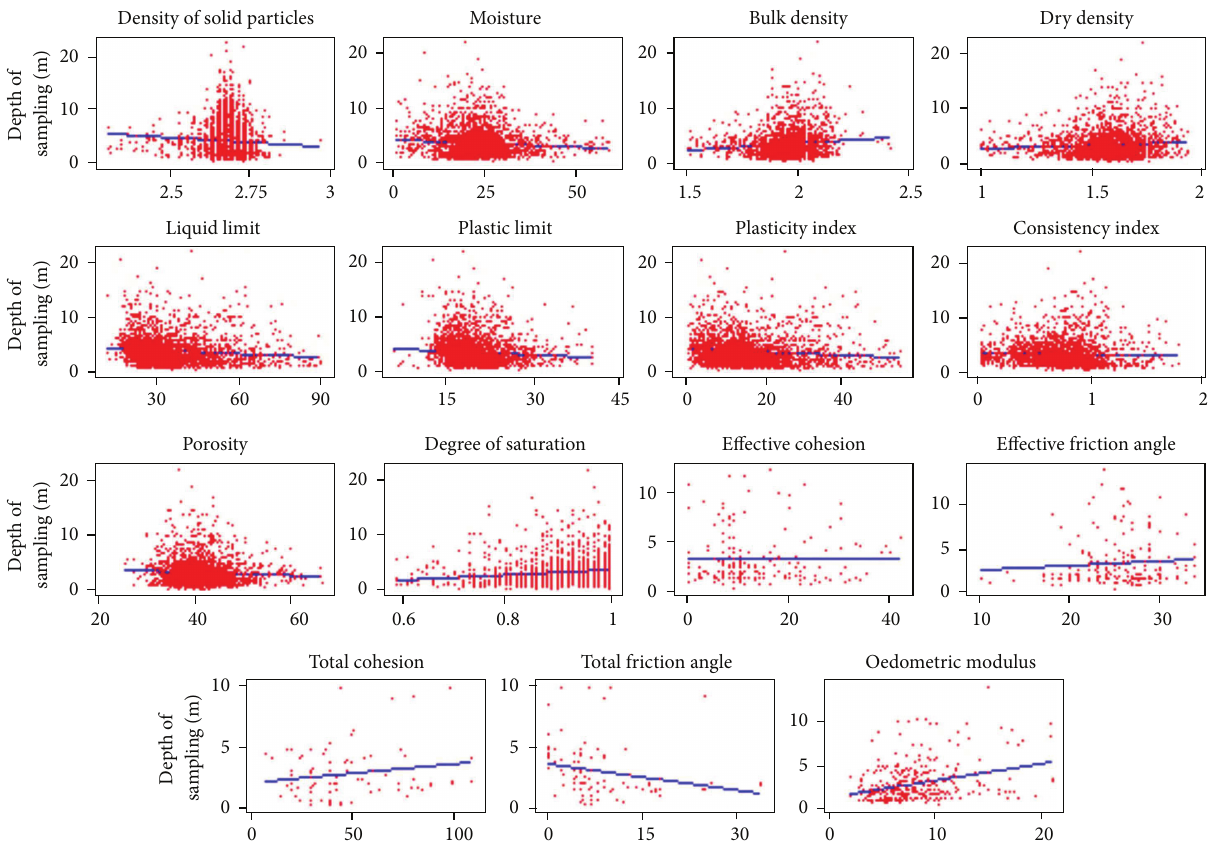
Figure 8: Example dependent of glacial soils on the